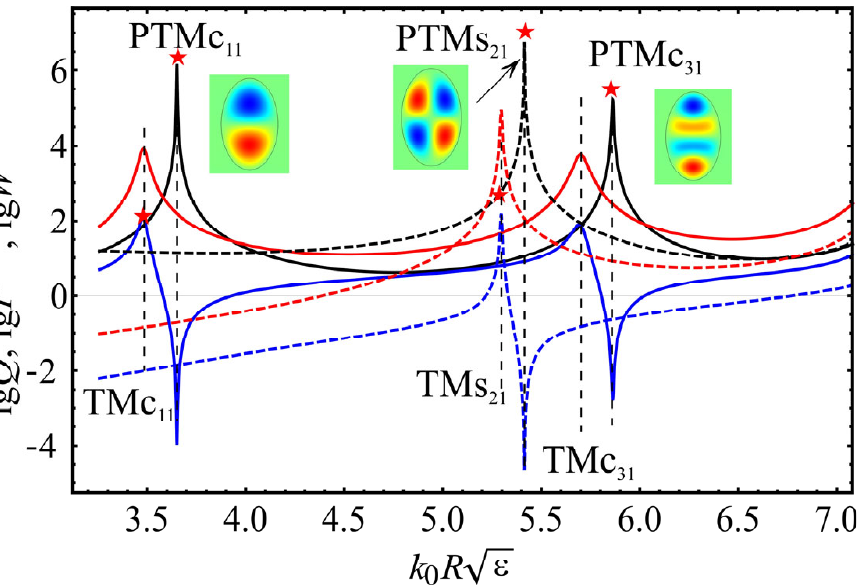
Figure 10. The dependence of scattered power lg P scat (blue curve), stored energy lg W stored (red curve), and radiation quality factor lg Q (black curve, (21)) on the size parameter k R ε of a waveguide with a / b = 1.6 obtained with Comsol Multiphysics. The solid curves correspond to the excitation field (19), and the dashed curves correspond to the excitation field (20), α = π /4. The vertical dashed lines show the position of the mode frequencies. The asterisks on the black curve show the Q factor value of the modes. The insets show the H z distribution for the perfect modes.